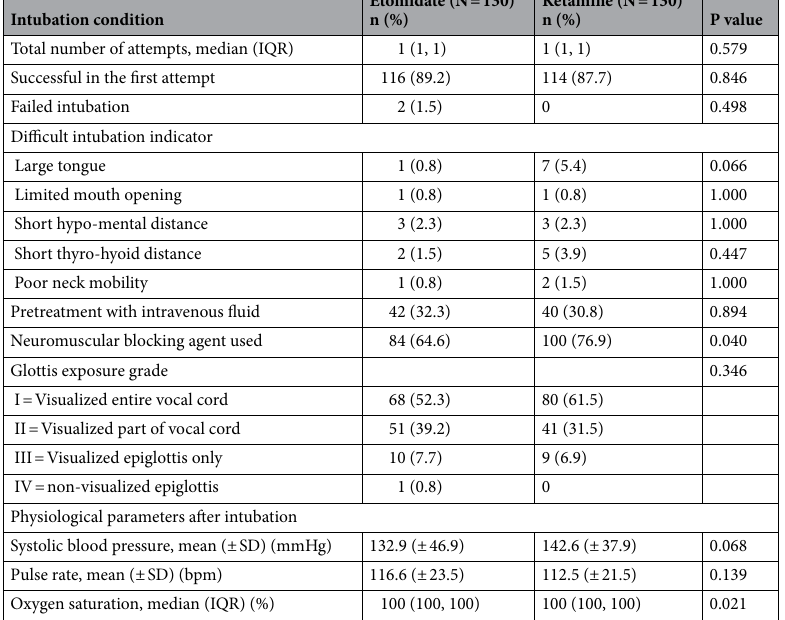
Table 2. Intubation conditions of the study patients.